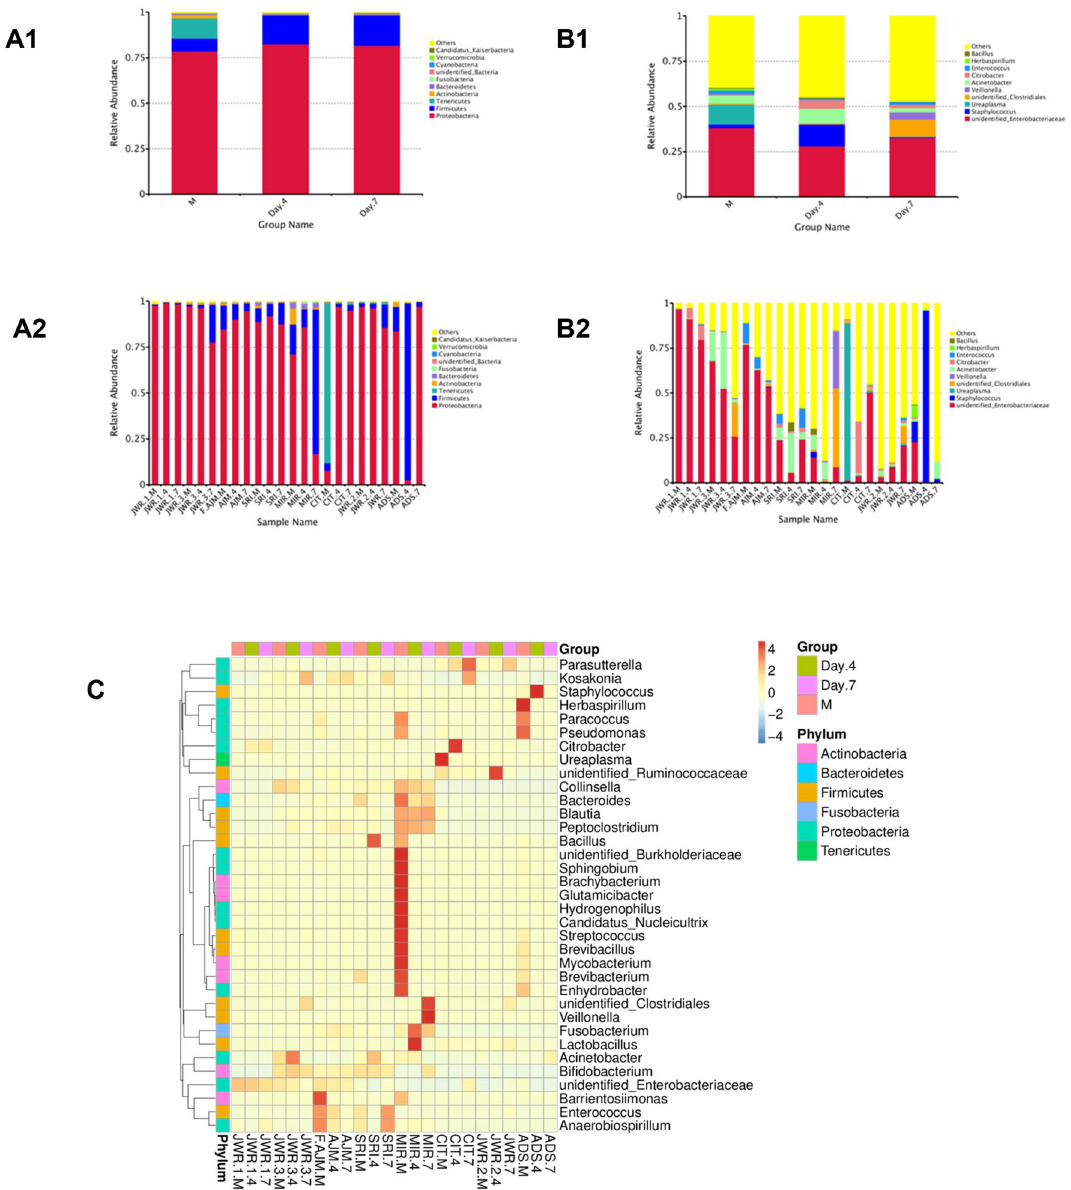
Figure 1. Analysis of OTUs and microbial composition in fecal samples at three time points for each subject. ( A1 ) and ( A2 ) show the results of analysis at the phylum level, whereas ( B1 ) and ( B2 ) show the results of analysis at the genus level, with all phylum and genus names designated in the figure legend inserts. ( A1 ) and ( B1 ) show the results for three time points, i.e., meconium (M), day 4 feces (Day 4) and day 7 feces (Day 7), while ( A2 ) and ( B2 ) show the three time points for each subject. All variation is shown in terms of relative abundance. ( C ) Heatmap of the relative abundance of 35 genera across three time points, with OTU proportions represented by bars. Generated by using R Software 24